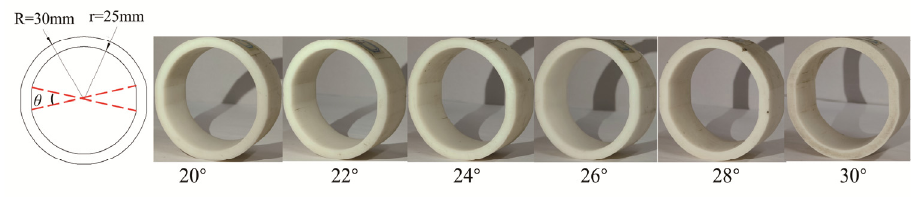
Figure 10. Mold sketch and 3D-printed molds.